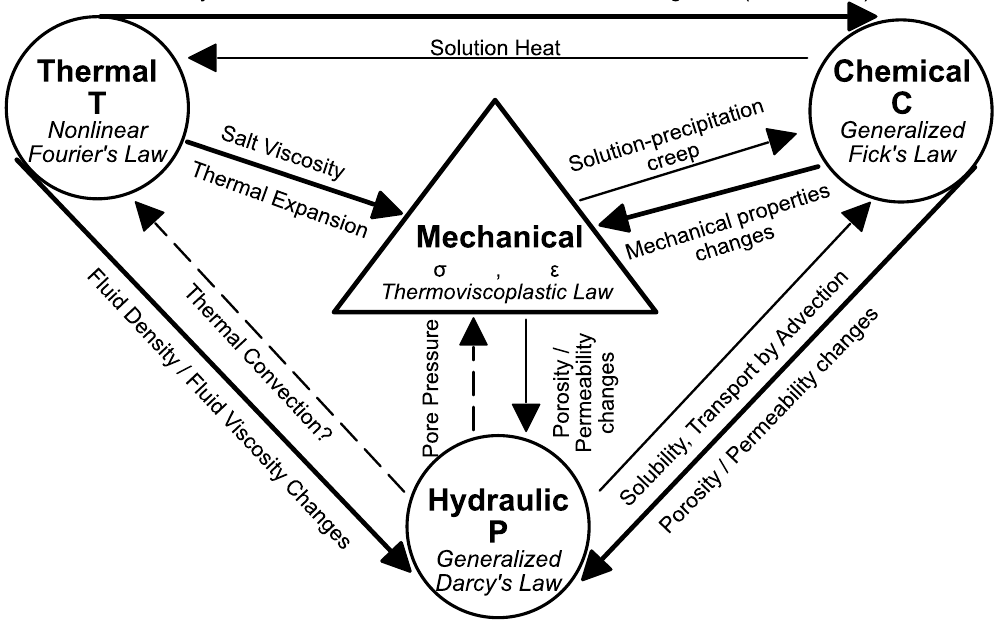
Figure 1. Thermal–Hydrological-Mechanical–Chemical (THMC) coupled processes in salt